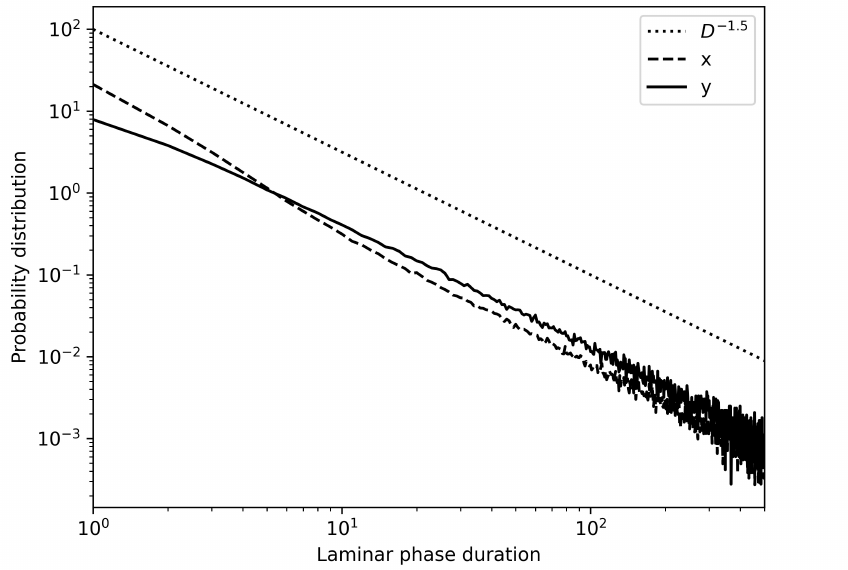
Figure 6. Laminar phase duration of the x (dashed) and y (solid) variables for stochastic variability of the carrying capacity K 0 in the case α = 1.4. The dotted line is proportional to D − 3 2 . For α = 1.5, x and y show chaotic dynamics, but the most intriguing phenomenon is related to the apparent on–off intermittency of z , as shown in Figure 7. A close inspection of the laminar phase durations, however shows that extended laminar periods are quite likely to occur, thus the curve is less steep than D − 3 2 .